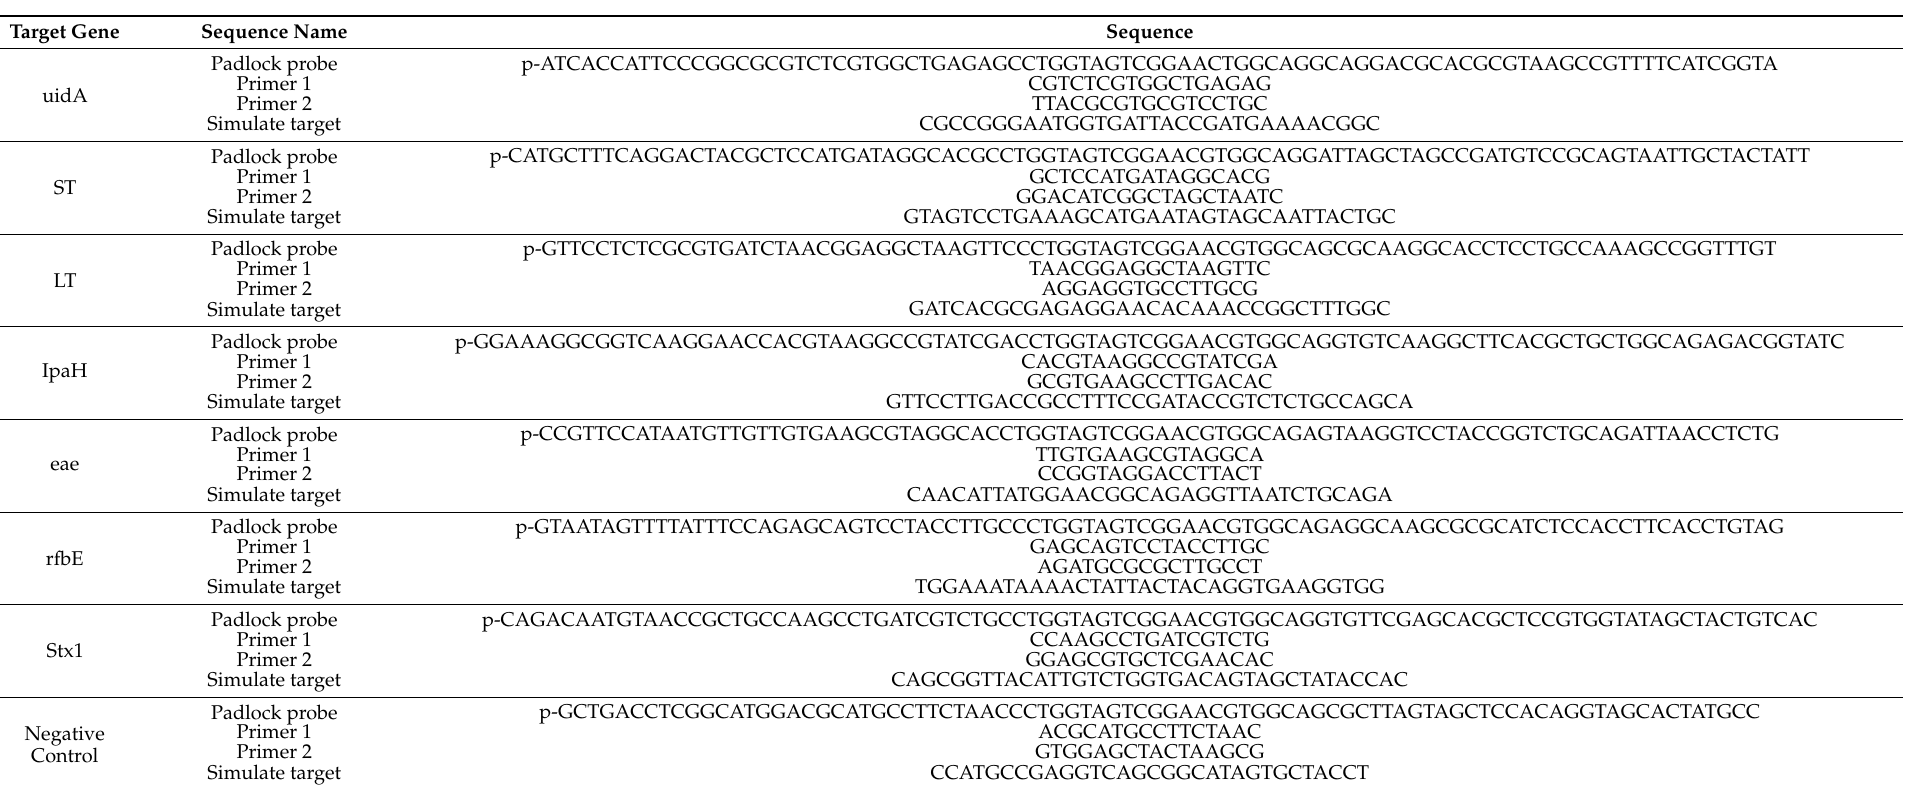
Table 2. Probes and primers